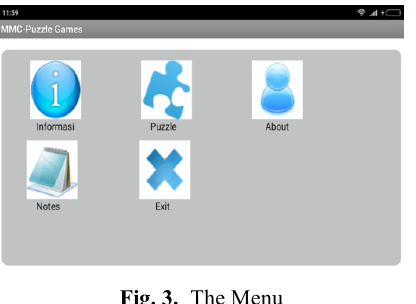
Fig. 4. The contents of the first menu of system